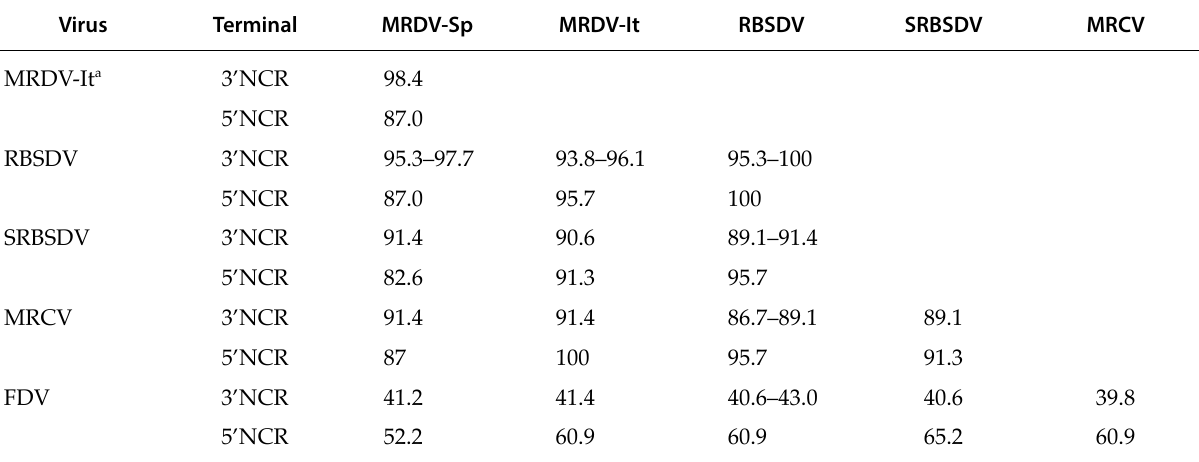
Table 6. Sequence identity (%) between species of the Fijivirus genus that infect maize at the 3’ and 5’ noncoding region of the segment